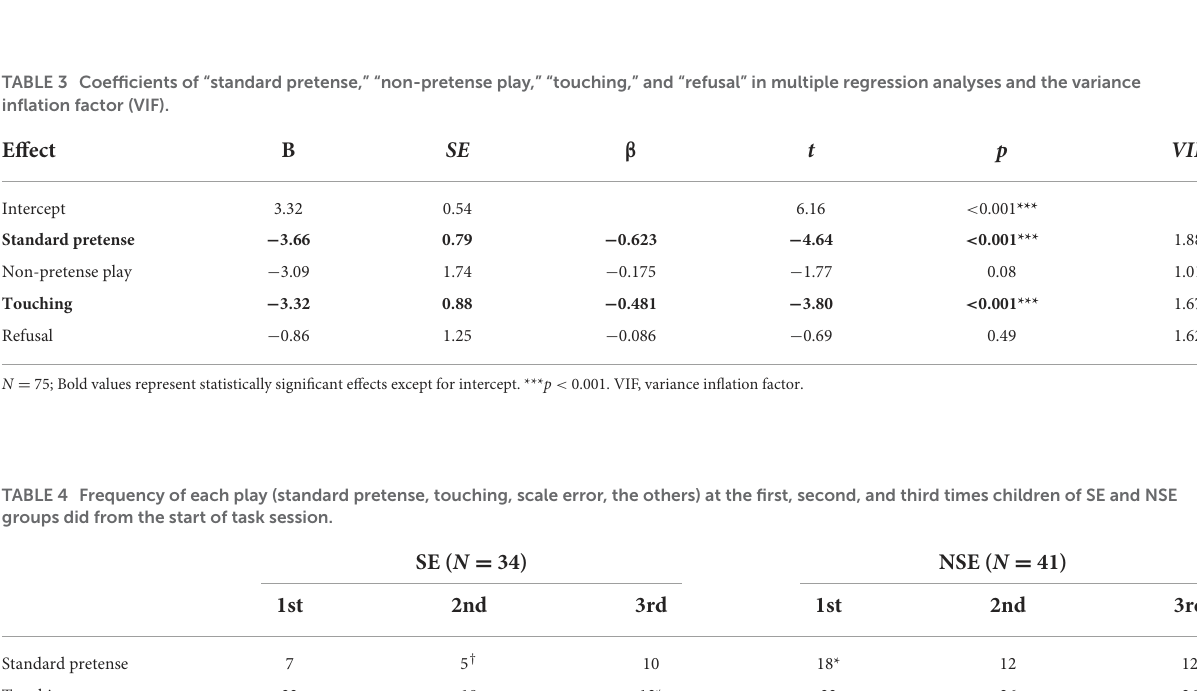
Standard pretense